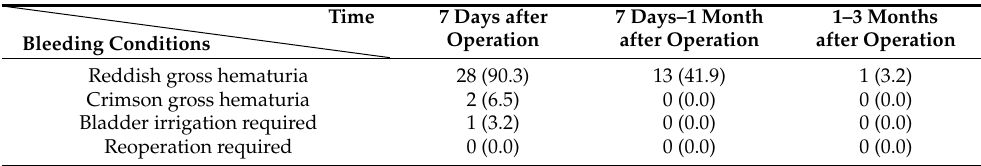
Table 4. Hemorrhage after TURP (n